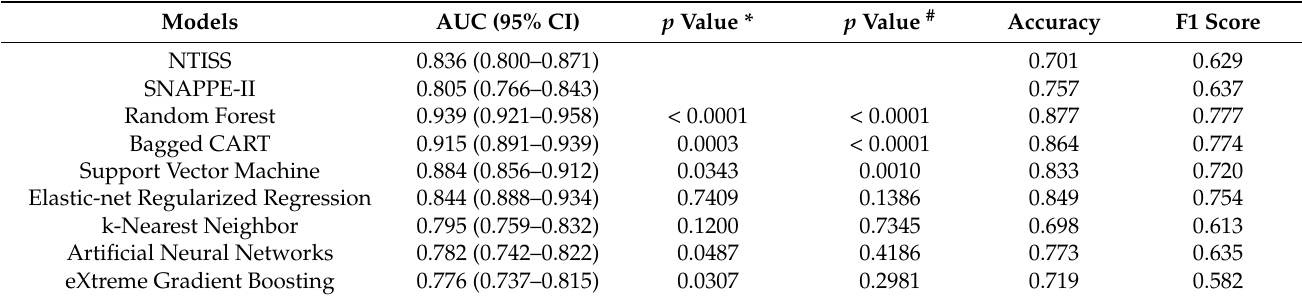
Table 2. Mortality prediction models for neonates on mechanical ventilation for severe respiratory failure in the test set.